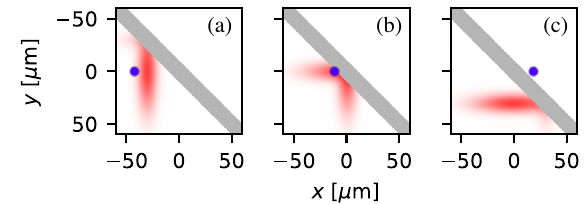
FIG. 1. Schematic of the interaction of an LWFA electron bunch (blue) with the laser pulse (red) reflected from a thin foil (gray): (a) Electron beam trails laser pulse propagating in the positive x direction. (b) Laser pulse is reflected from foil and interacts with electron beam. (c) Electron beam passes through foil and is separated from the laser